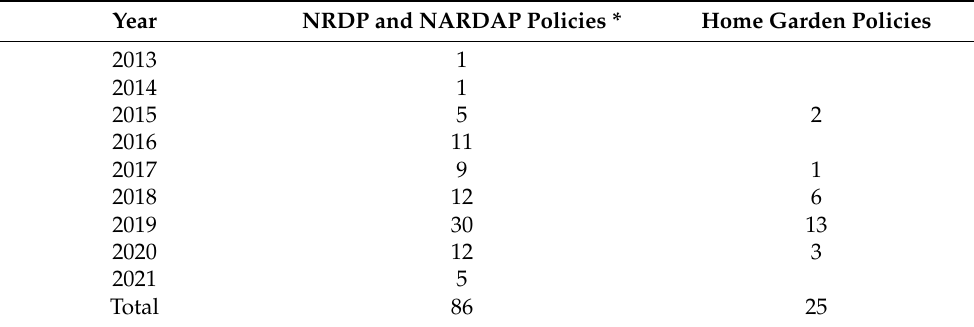
Table 1. Number of home garden policies enacted over the last decade. Year NRDP and NARDAP Policies * Home Garden Policies